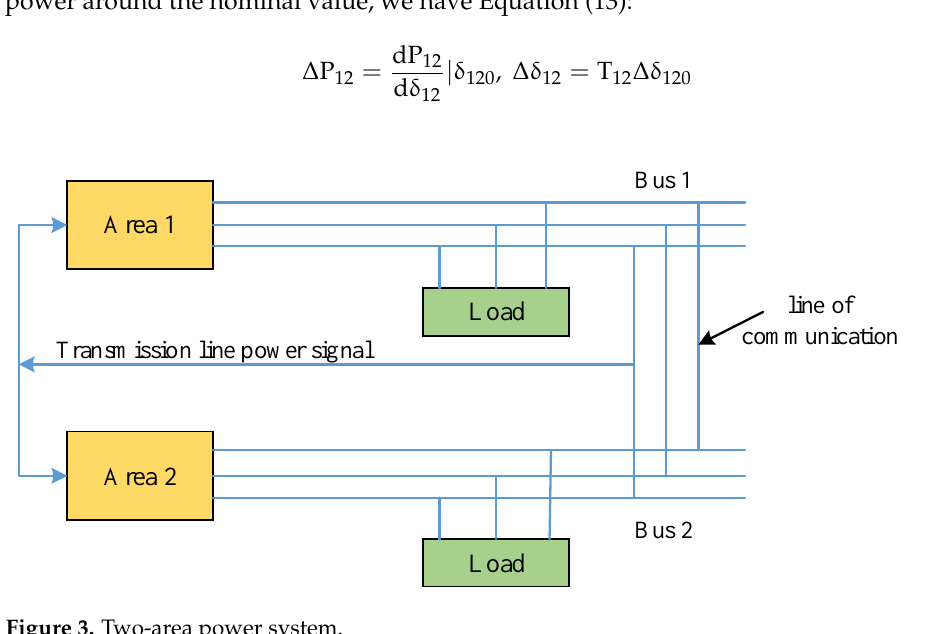
Figure 3. Two-area power system.